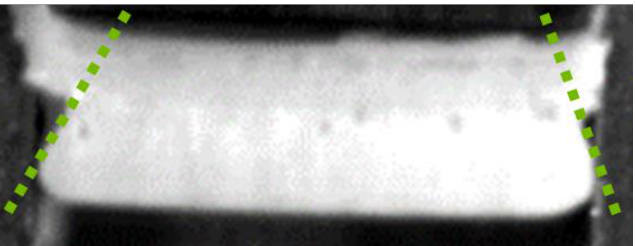
Figure 4. Simulated ideal crack propagation shown with dashed lines on a slug. The dotted lines